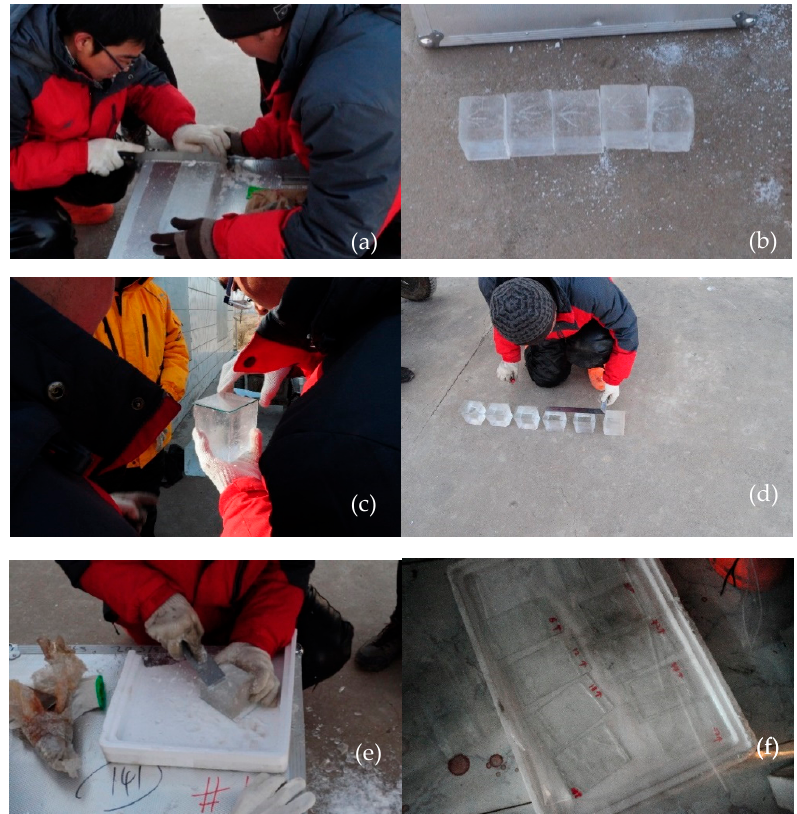
Figure 2. Preparation process of ice slices: ( a ) sawing ice; ( b ) labeling ice samples; ( c ) adhering ice samples to glass sheets; ( d ) checking adhesion of ice blocks; ( e ) planning an ice slice; ( f ) well-polished ice slices.